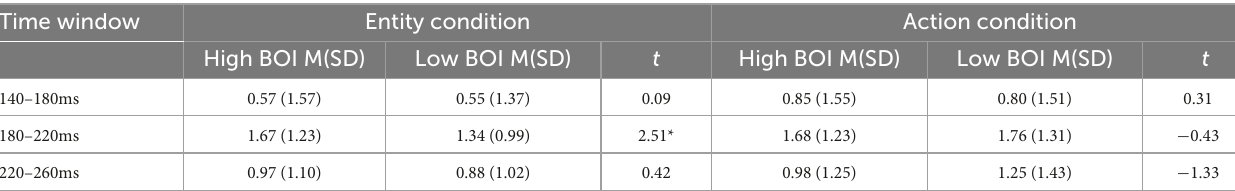
TABLE 4 P2 mean amplitude, standard deviations, and t -tests by task condition, word type, and time window. Time window